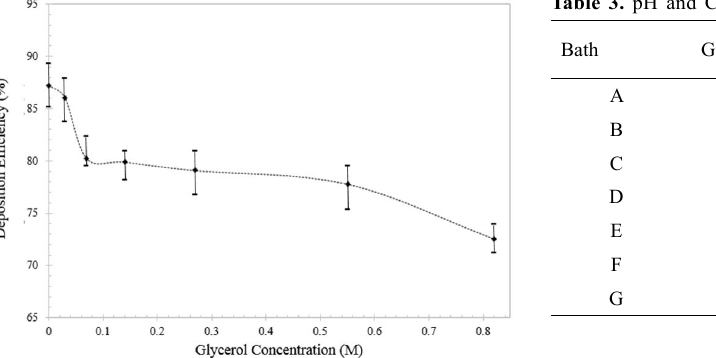
BO 0.32M) on the current efficiency 3 3